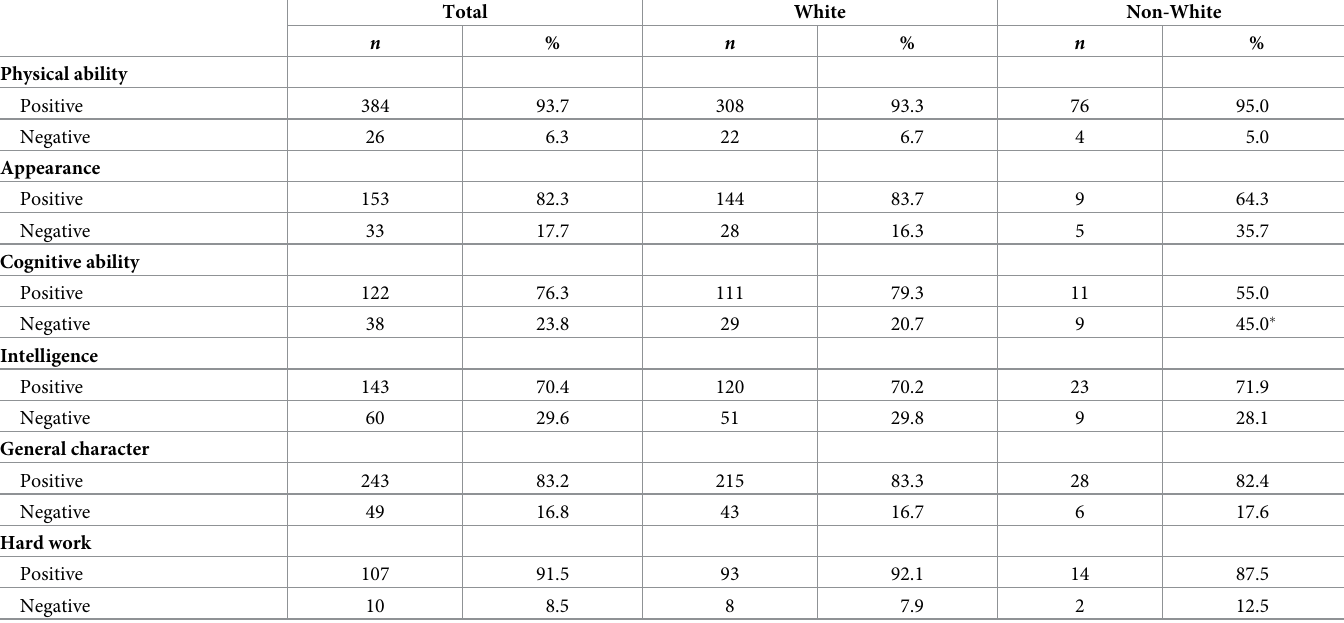
Table 5. Proportion of positive and negative statements by race within each attribute